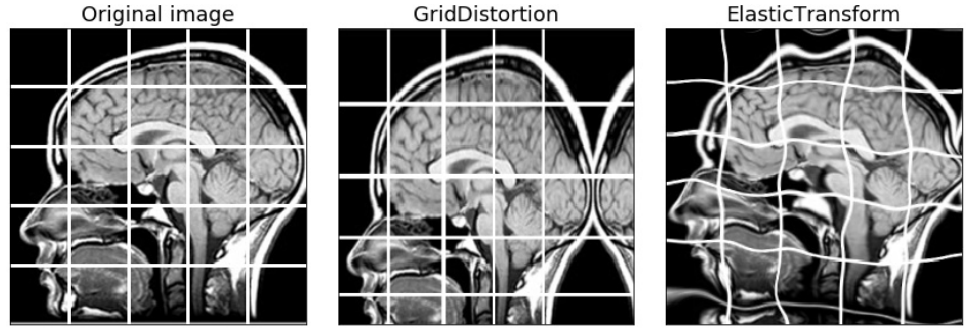
Figure 2. Grid distortion and elastic transform applied to a medical